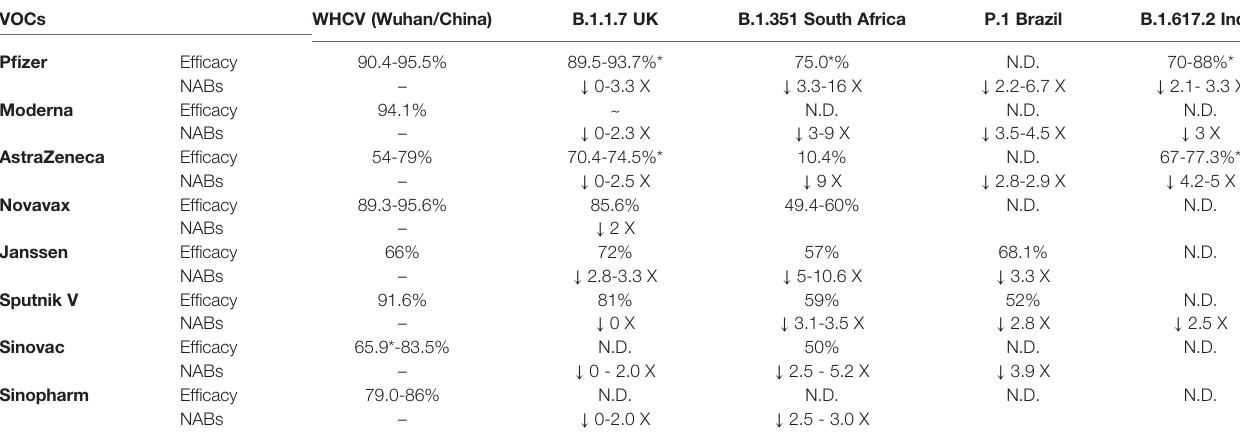
TABLE 1 | VOCs and vaccine-induced immune response